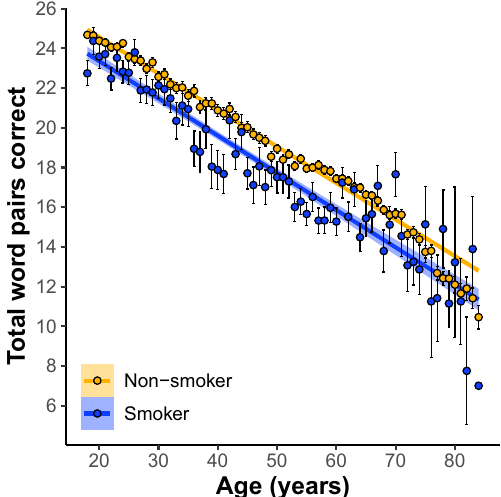
Figure 1. Participants who self-report current smoker status perform worse on paired-associates learning (PAL) compared to non-smokers across 18–85 year olds. Linear regression fit (line fill ± 95% confidence interval (CI)) of the PAL total number of correct from 18 to 85 years old. Lines were split by Smoker versus Non-smoker. (F(30, 81,670) = 560. 58, p = 0e+00, N = 81, 700).